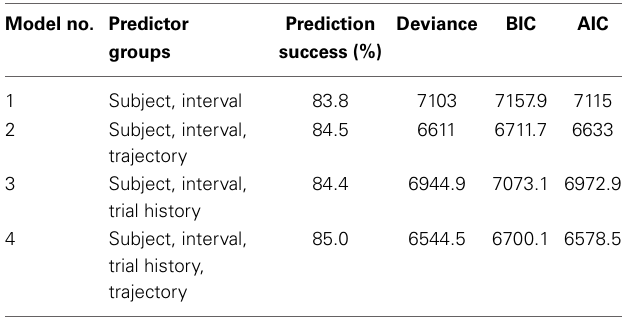
Table 1 | Behavioral trajectories improve choice prediction beyond trial